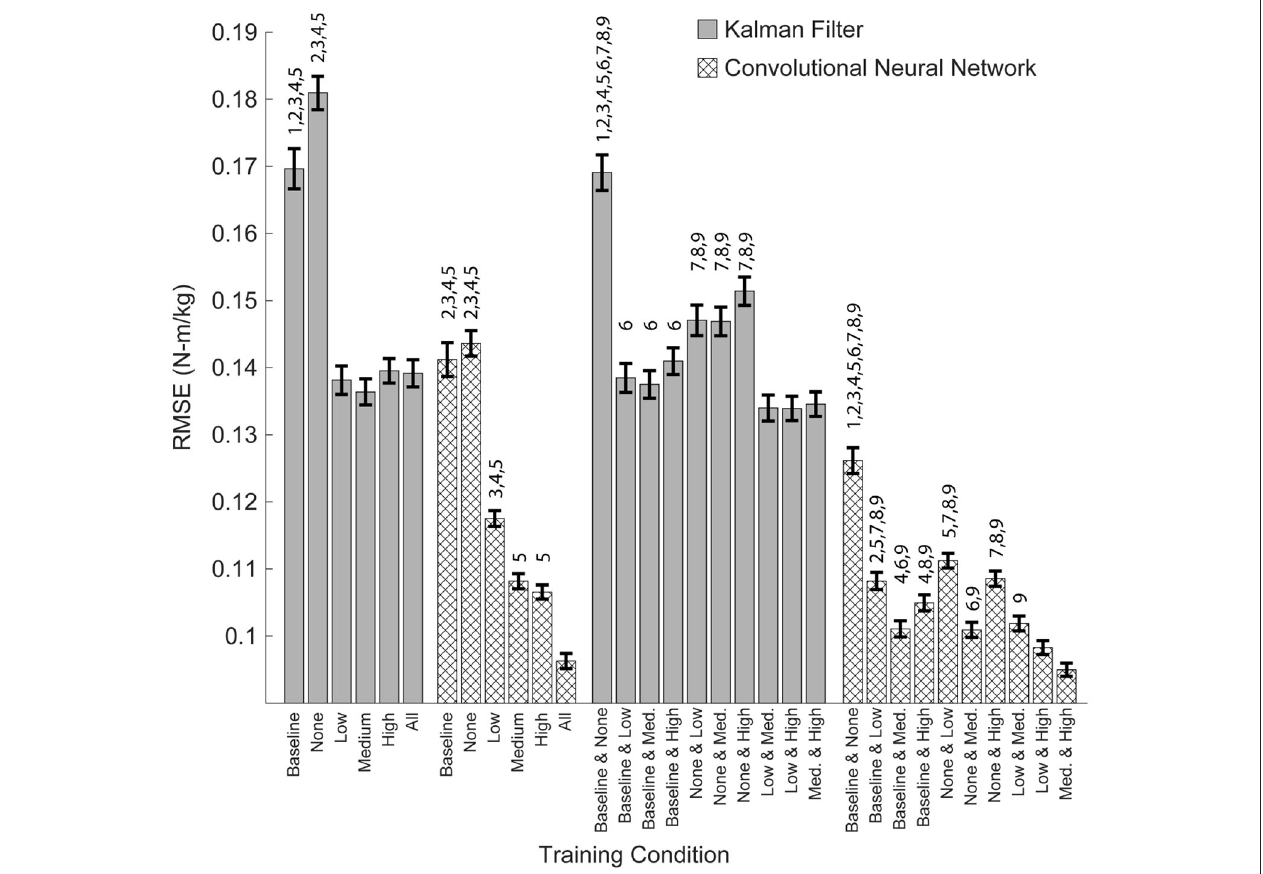
FIGURE 7 | Overall algorithm performance when predicting torque during low, medium and high levels of exoskeleton assistance. Performance is shown as RMSE (N-m/kg) of algorithm predictions relative to the ground truth values of right and left hip torque in the sagittal plane. Training on data from multiple levels of exoskeleton assistance improved the overall performance of the CNN, but not the KF. Bars show mean ± standard error of the mean. Numbers above the bars denote statistical significance for the algorithm within the subset of adjacent conditions (multiple pair-wise comparisons using the Dunn-Sidak correction for multiple comparison). Conditions within the subsets are numbered from 0 to 6, left to right (Baseline = 0, High = 5), or from 0 to 9, left to right (Baseline and None = 0, Med. and High = 9).